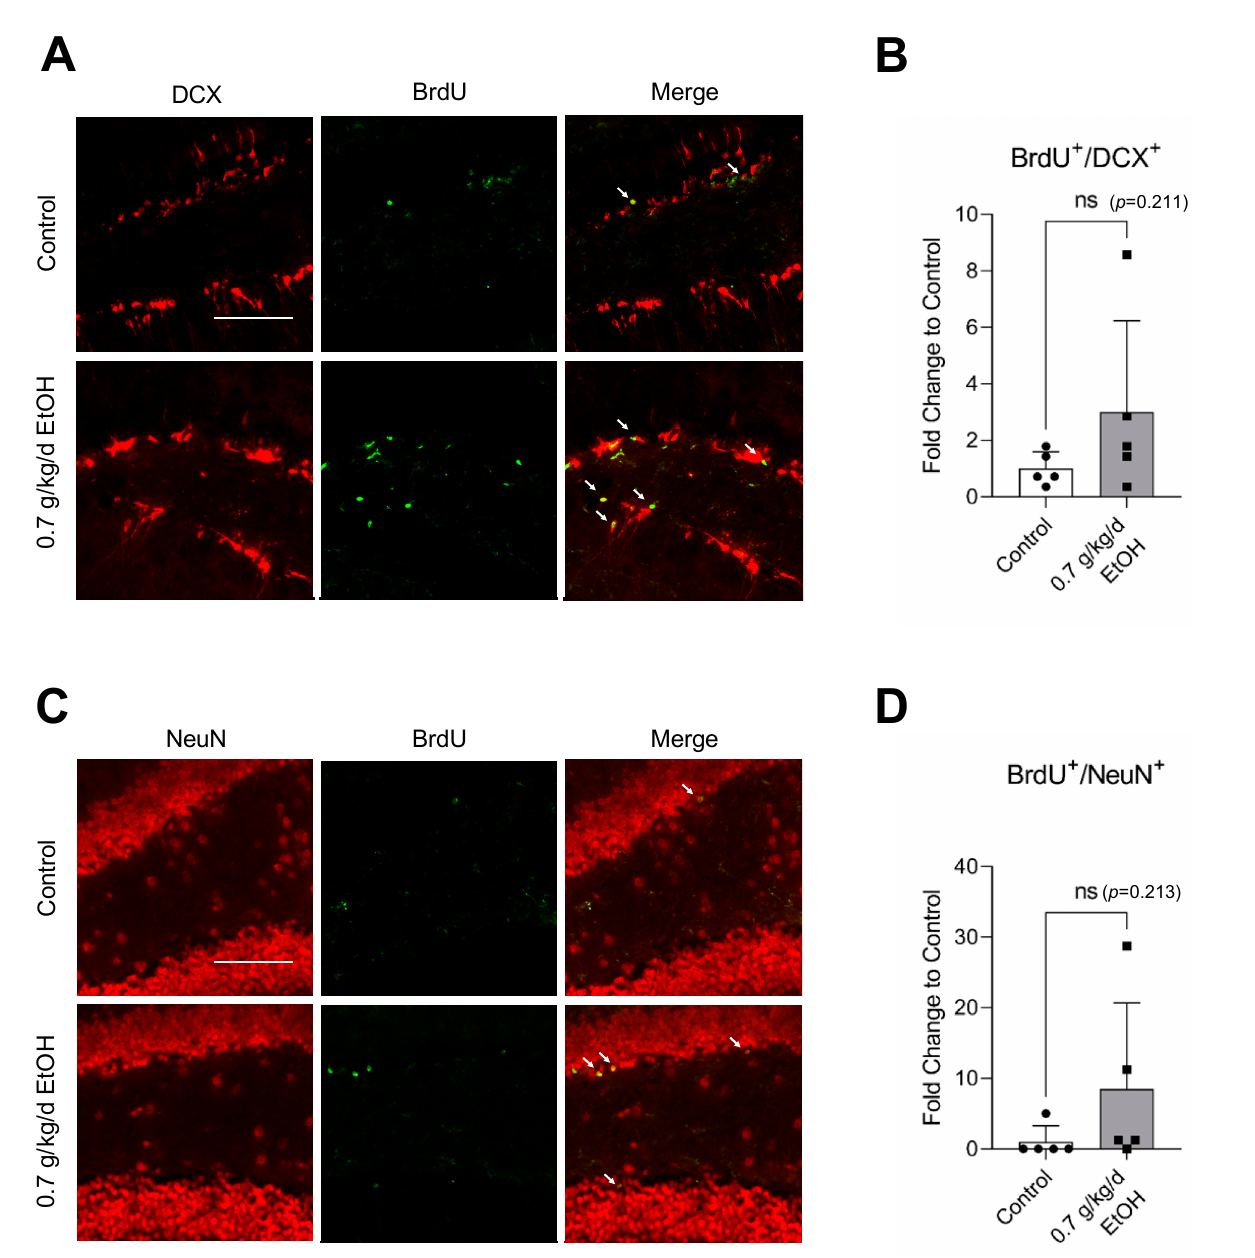
Figure 2. Effect of LAC on baseline neurogenesis in the DG. ( A ) Representative double staining of BrdU and DCX. Scale bar = 100 µm. ( B ) Values are means ± SD ( n = 5). ( C ) Representative double staining of BrdU and NeuN. ( D ) Values are means ± SD ( n = 5). Analyzed using an unpaired t -test.